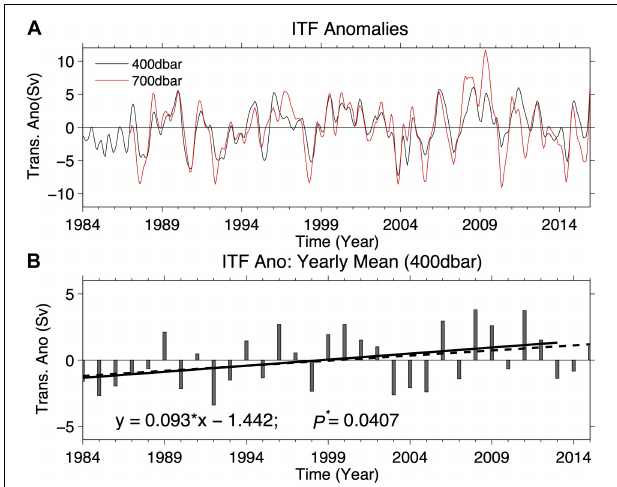
FIGURE 8 | The ITF geostrophic transport anomalies estimated from IX1 XBT data in the southeast Indian Ocean. (A) A monthly time series of the ITF transport anomalies estimated by IX1 XBT temperature records and monthly T-S relationship with reference depths of 400 m (black line) and 700 m (red line) from January 1984 to December 2015. Negative is toward the Indian Ocean (i.e., stronger ITF). (B) Annual mean ITF transport anomalies with a reference depth of 400 db (bars) and their linear trends (lines) during 1984–2013 and during 1984–2015 (Figure from Feng et al., 2018. Permission obtained from